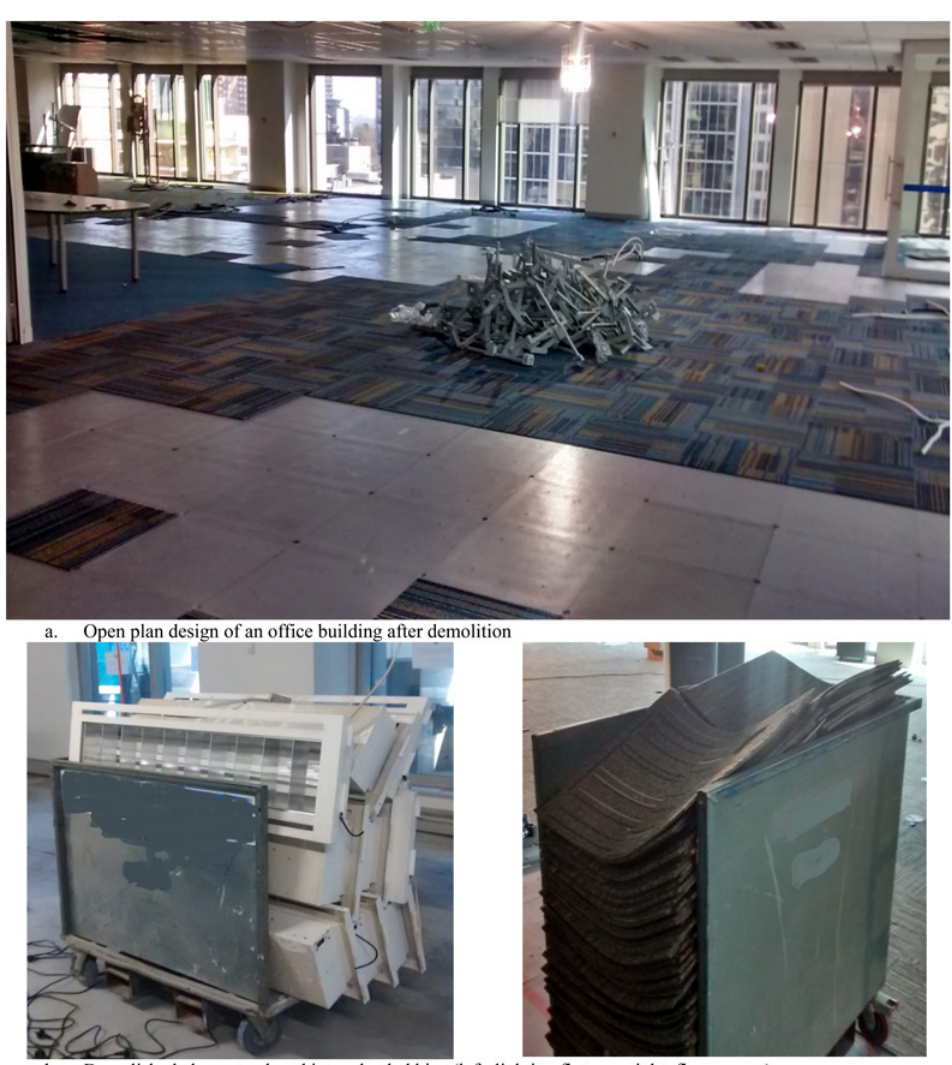
Views from office fit-out demolition: a) open plan view after demolition b) demolished